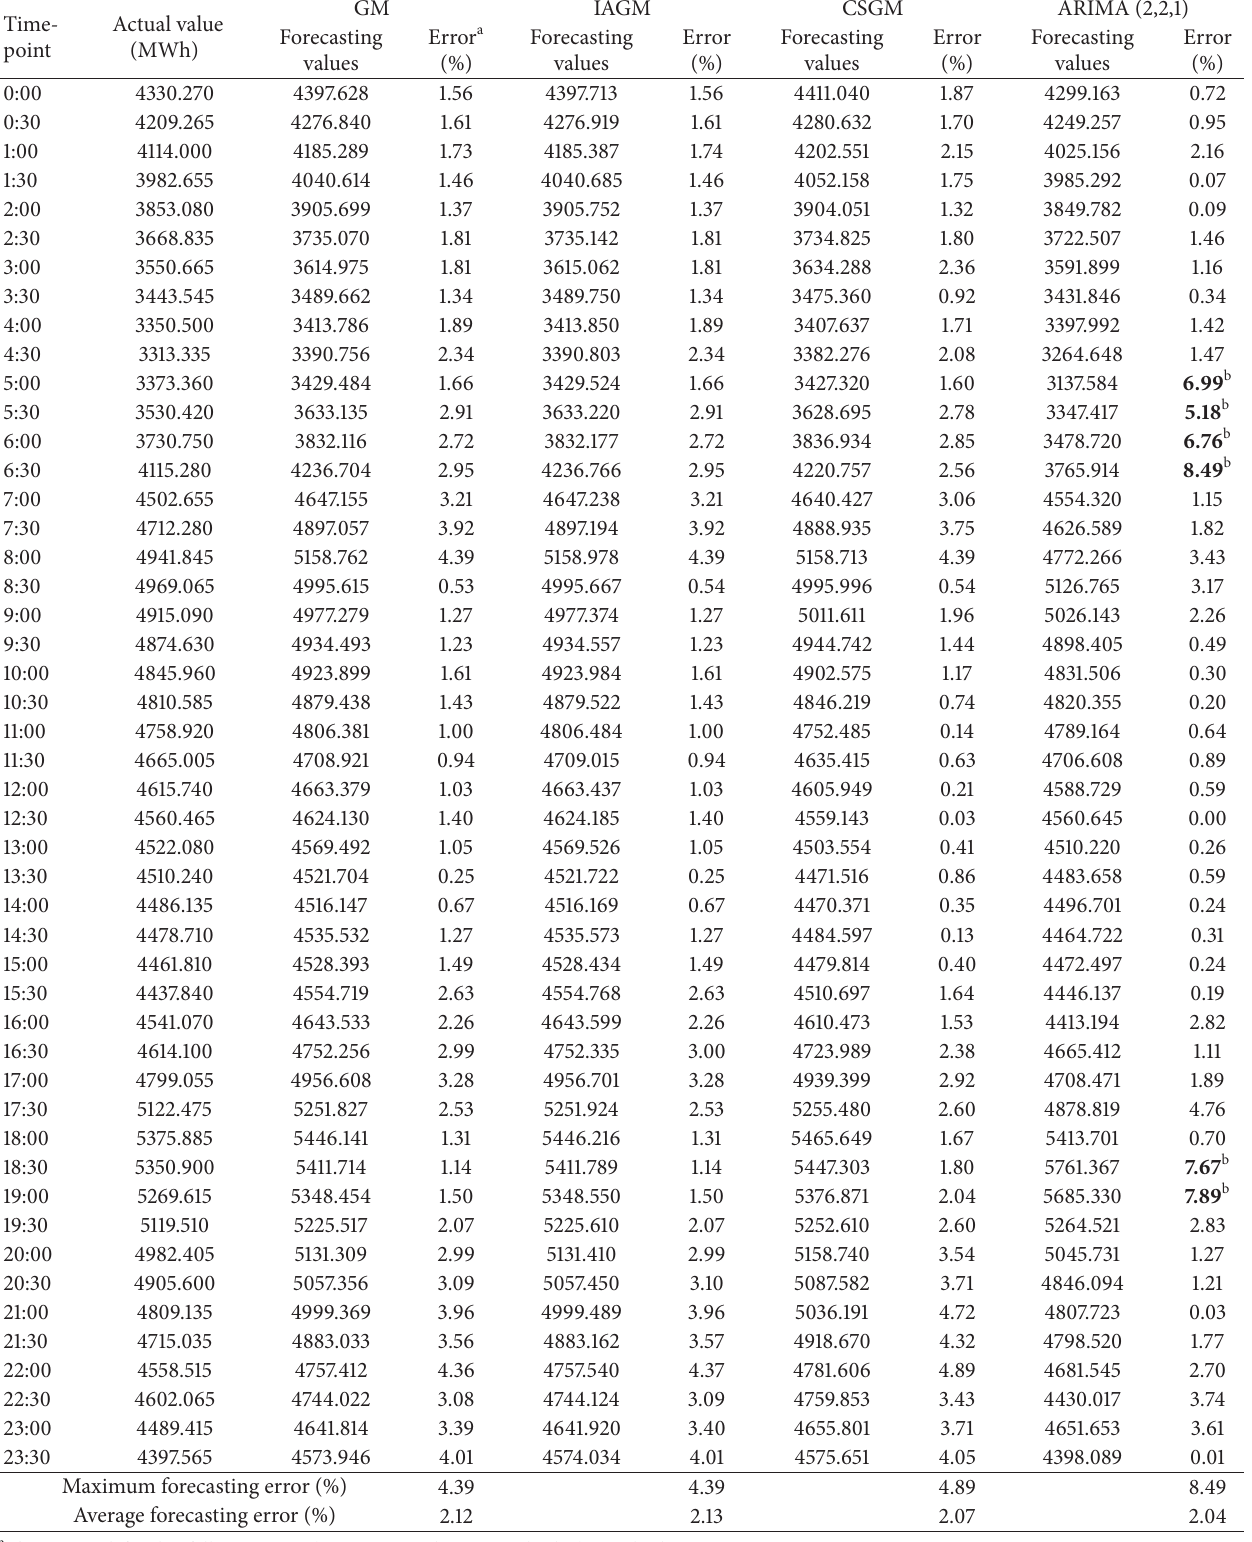
Table 1: Electricity consumption forecasting